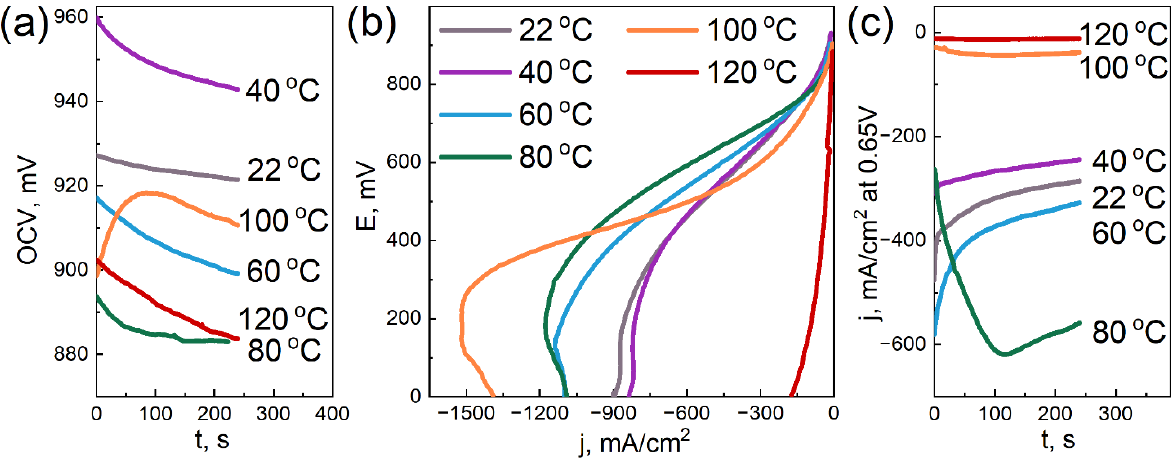
Figure 7. Electrochemical characteristics of the MEA with the Aquivion ® -type membrane (EW = 897 g-eq/mol) with a 0.5 wt.% DND Z+ at different temperatures: OCV vs. time ( a ); voltammograms ( b ); and current density in the potentiostatic mode at a voltage of 0.65 V vs. time ( c ).